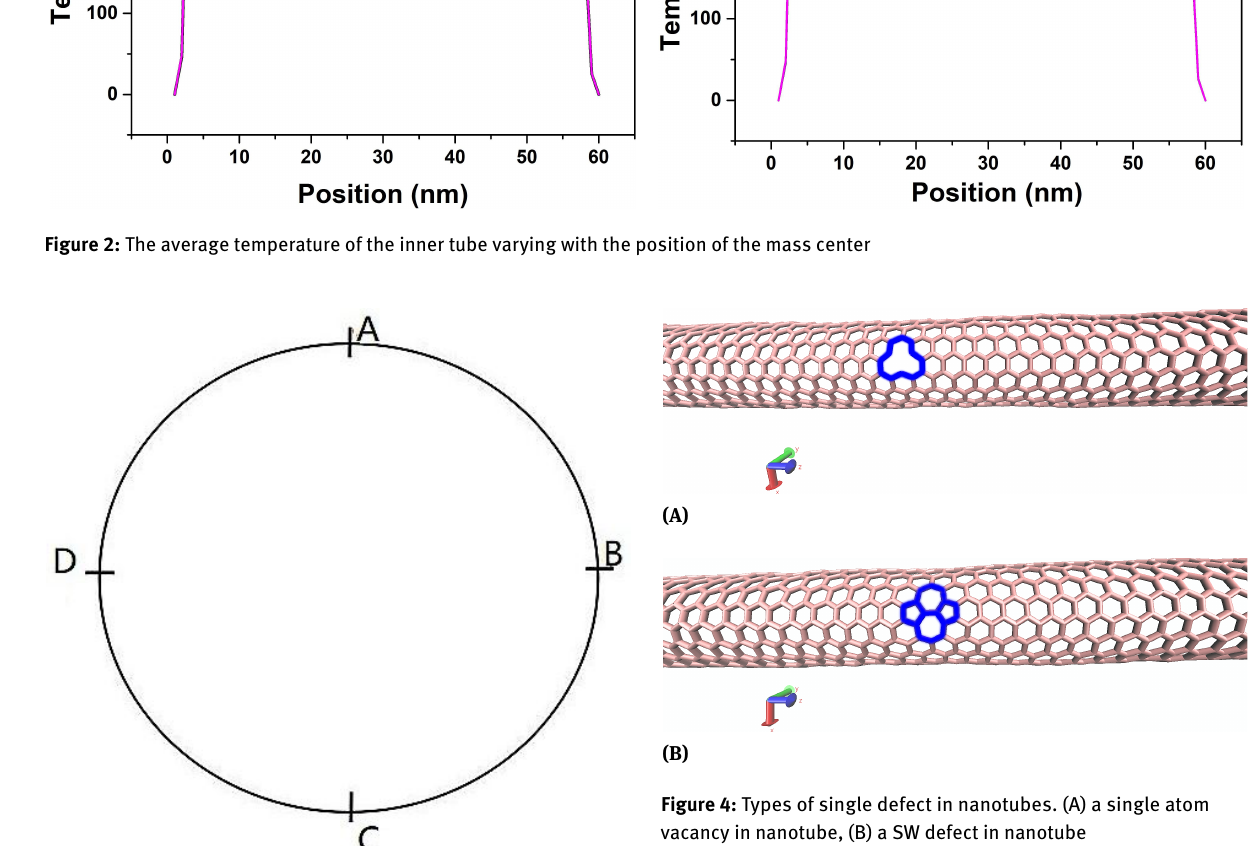
three defect types are used, 2 vacancy defects adjacent, 2 vacancy defects opposite, 4 vacancy defects. The variation of position, velocity of the outer nanotube versus time dur- ing the process are shown in Figures 5(a) and (b) respec- tively. It can be seen from Figure 5(a) and (b) that the pres- ence of single atom vacancy defects reduces the movement magnitude and increases the cycle time, which indicates that energy dissipation and damping effect are introduced to the system by the single atom vacancy defects. It shows that the extent of damping is different for different situa- tions. The system with 4 defects undergoes the largest re- duction in magnitude and also the largest increase in cycle time, while less damping effects are observed in the sys- tems with 2 defects opposite and 2 defects adjacent.